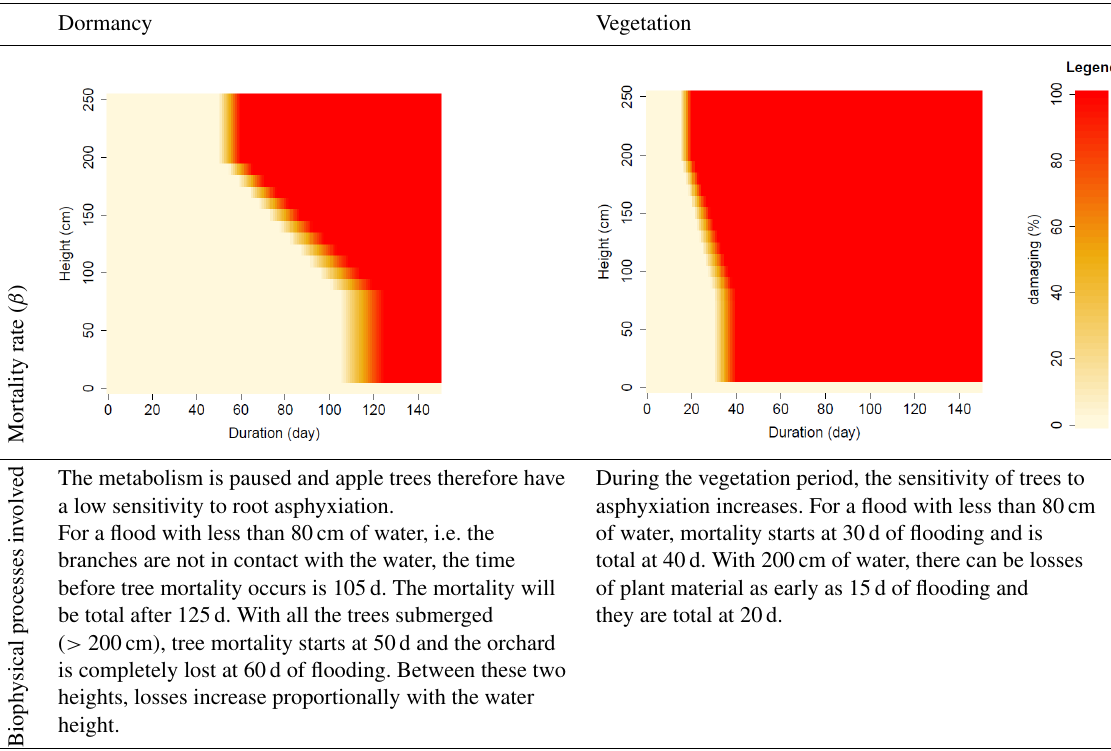
Table 3. Mortality of plant material for apple crop as a function of the physiological stages and biophysical processes involved (low velocity). Dormancy